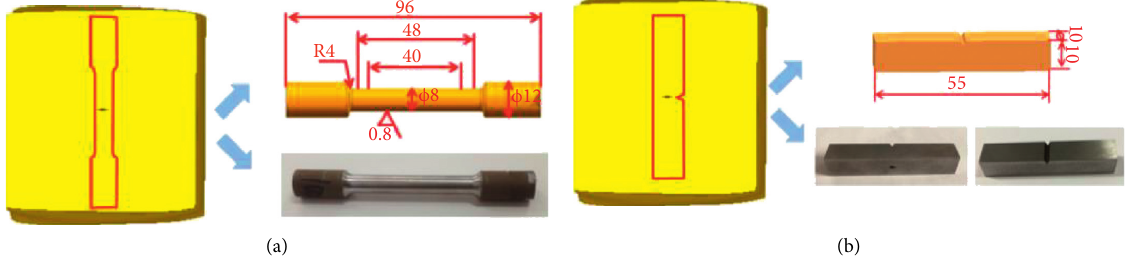
Figure 3: (a) Sampling diagram of the tensile sample. (b) Sampling diagram of the impact sample (unit: